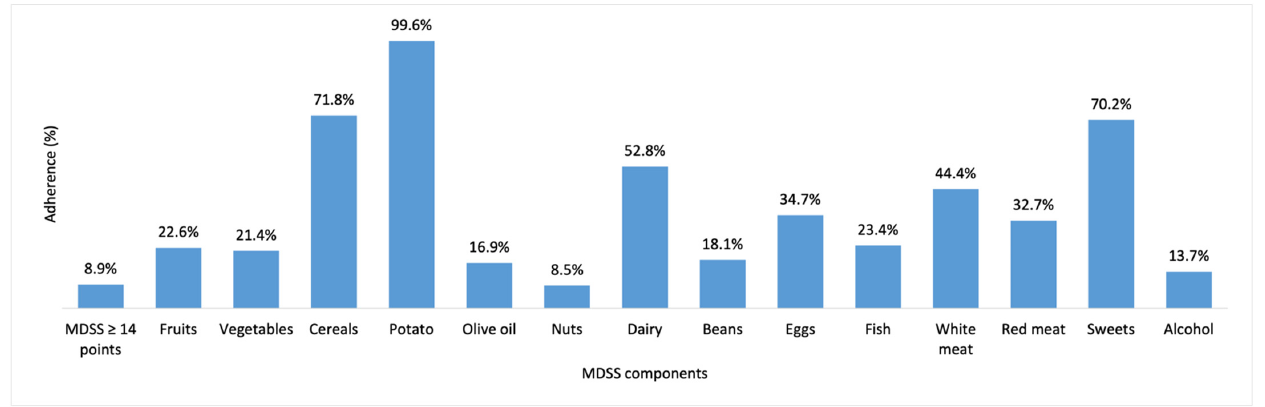
Figure 2. Overall adherence to the MeDi and its components among all study participants. Abbrevia- tions: MDSS, Mediterranean Diet Serving